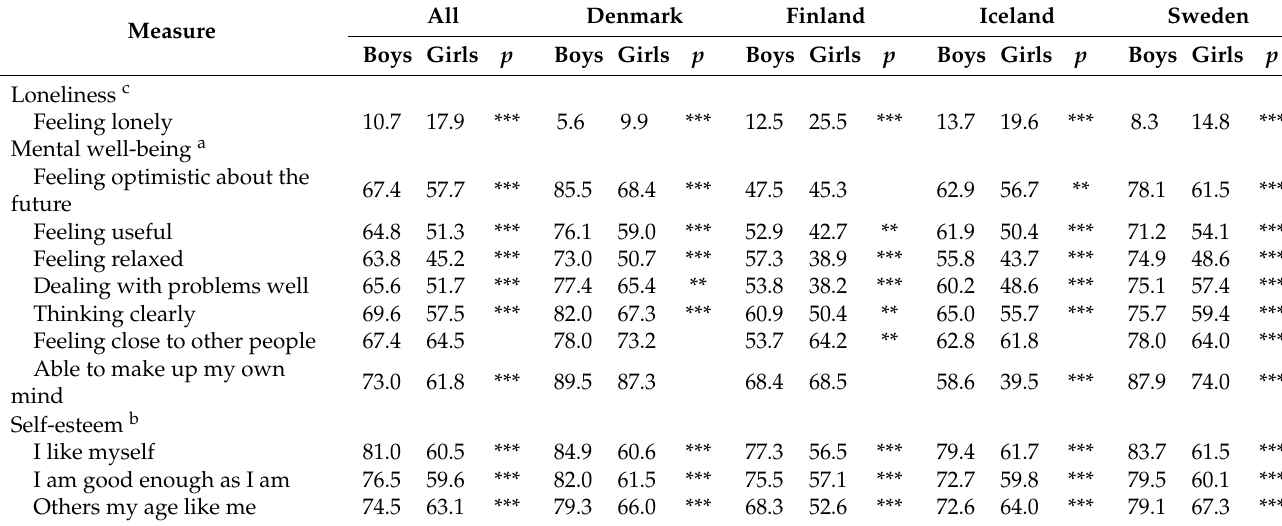
Table 2. Prevalences of adolescent boys ( n = 2740 to 2840) and girls ( n = 2883 to 2922) reporting loneliness, positive mental health, and high